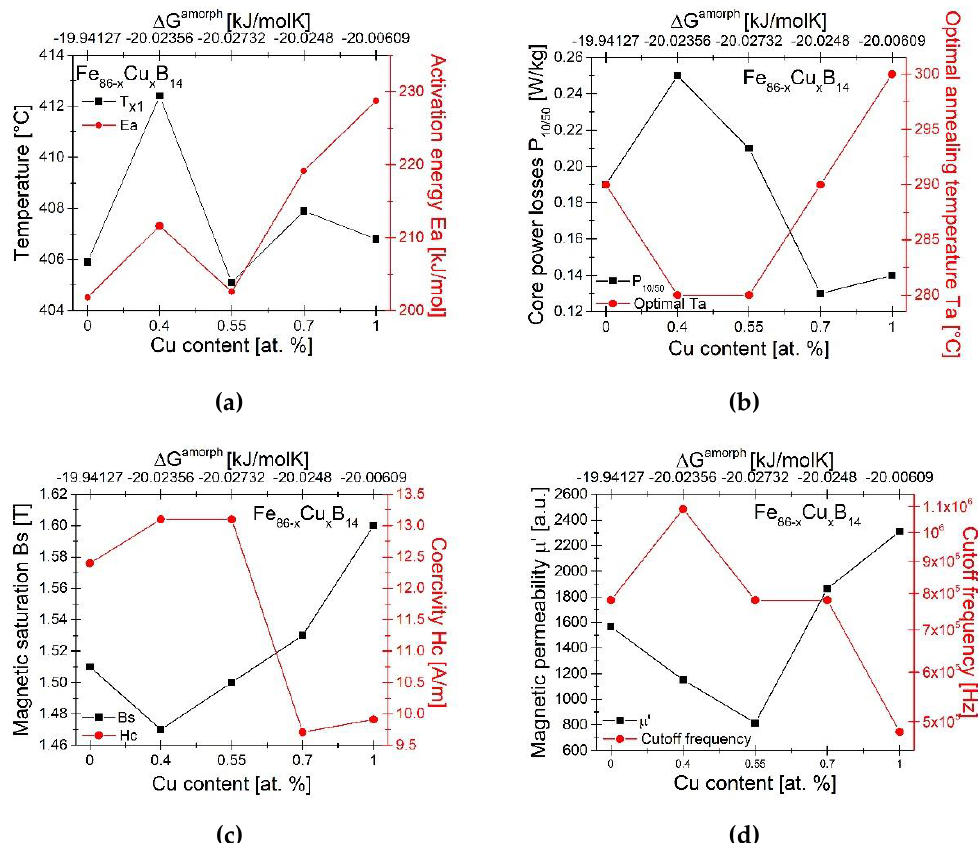
Figure 10. Influence of Cu content and Gibbs free energy of amorphous phase formation ΔG amorph on: characteristic crystallization temperatures at heating rate 20 ° C/min and average activation energy Ea ( a ), optimal annealing temperature Ta and magnetic properties at optimal Ta: core power losses P 10/50 ( b ), magnetic saturation Bs and coercivity Hc ( c ), magnetic permeability µ’ and cutoff frequency ( d ).